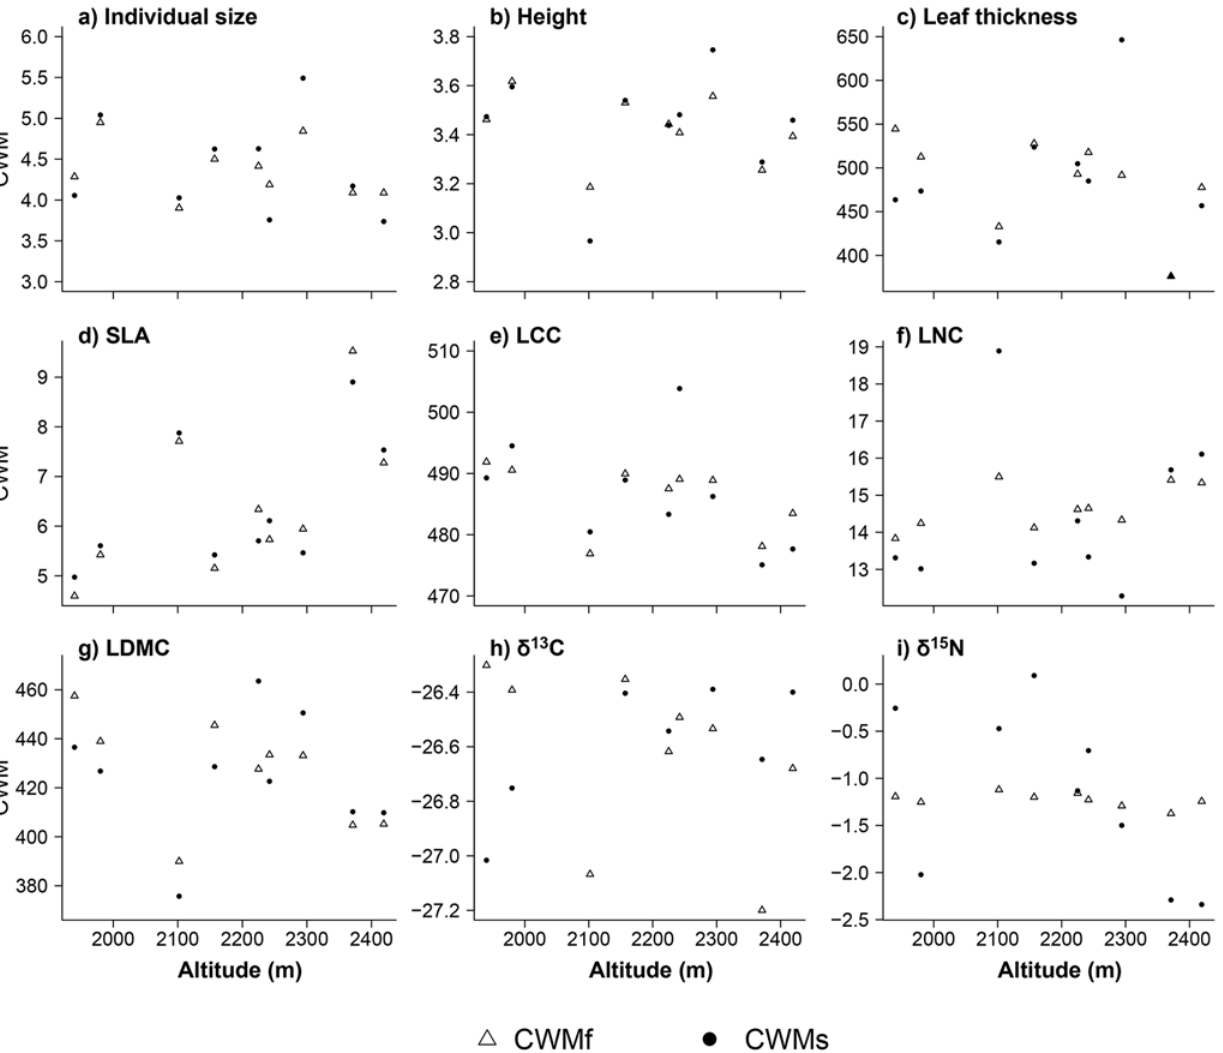
Fig 3. Variation of community weighted means values (CWM) along altitudinal gradient for each functional trait (a-i). Response of two CWM values along altitudinal gradient: using mean trait value measured for each species across all sites (CWM f — open triangles) and mean trait value at each site (CWM s — black dots). Trait labels are the same as in Fig.